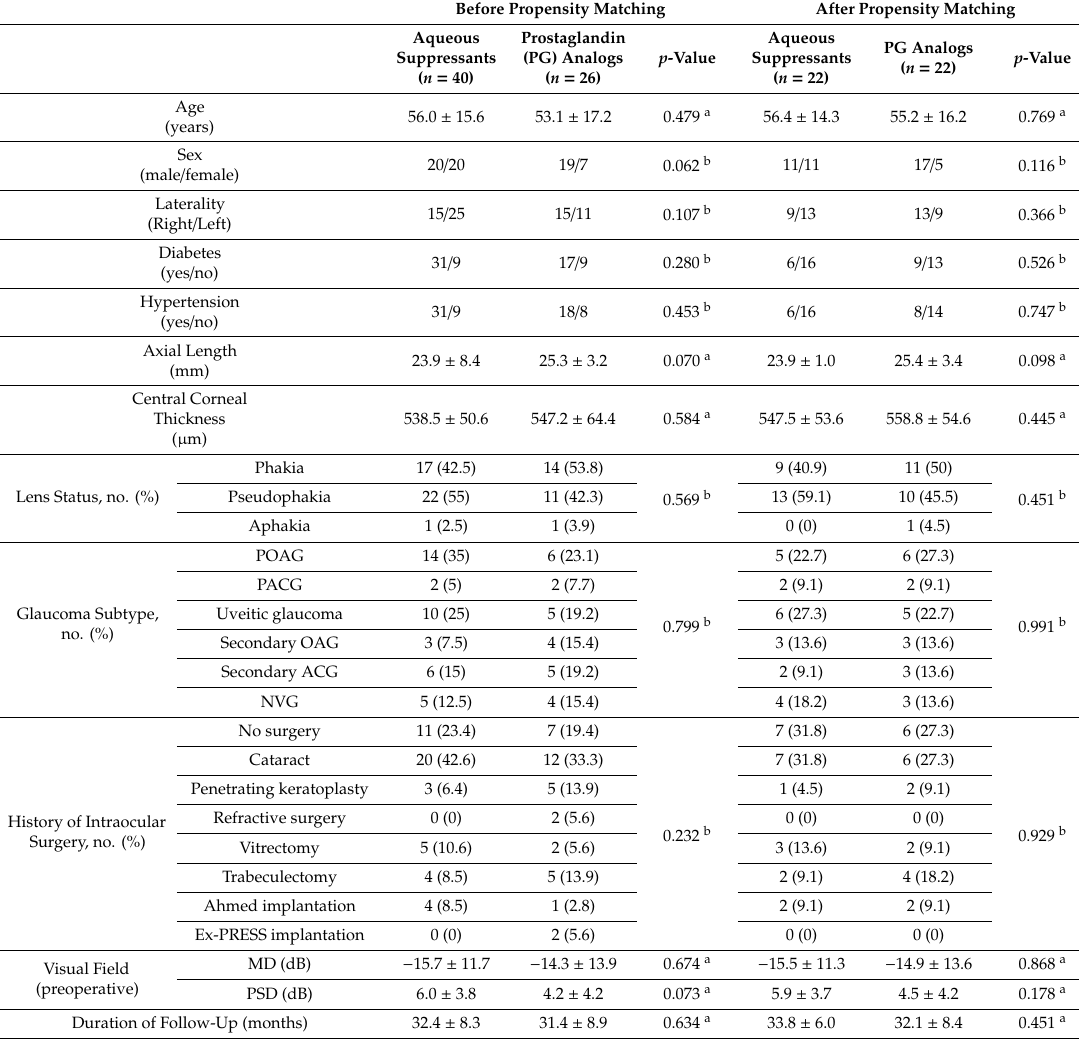
Table 1. Demographic characteristics of the study